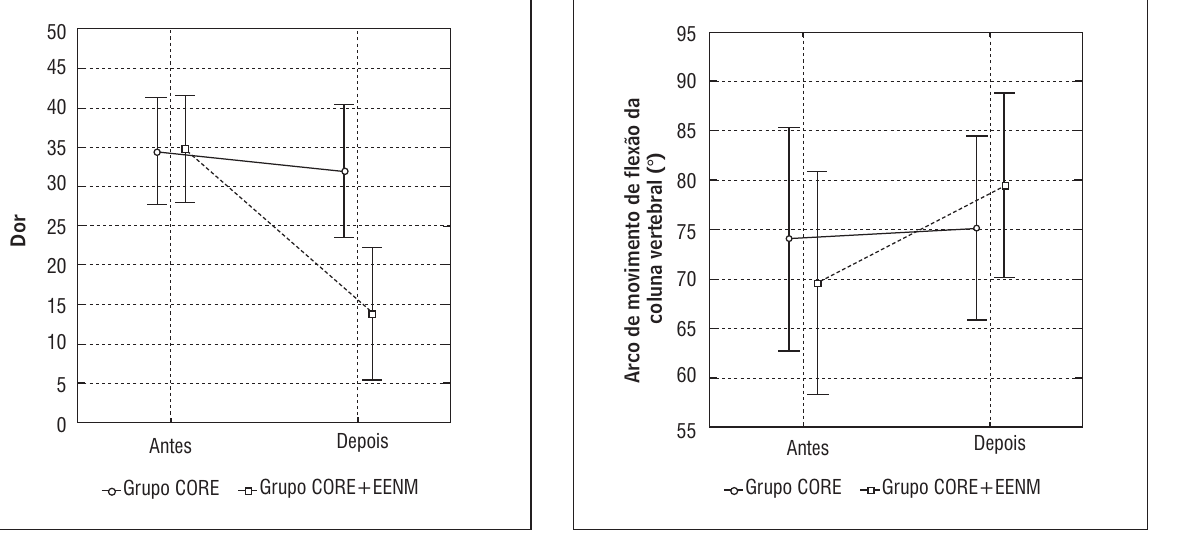
Figura 1 - Valores médios de dor (McGill) antes e depois das intervenções. Legenda: As barras representam 95% do intervalo de con fi ança. Fonte: Dados da pesquisa.